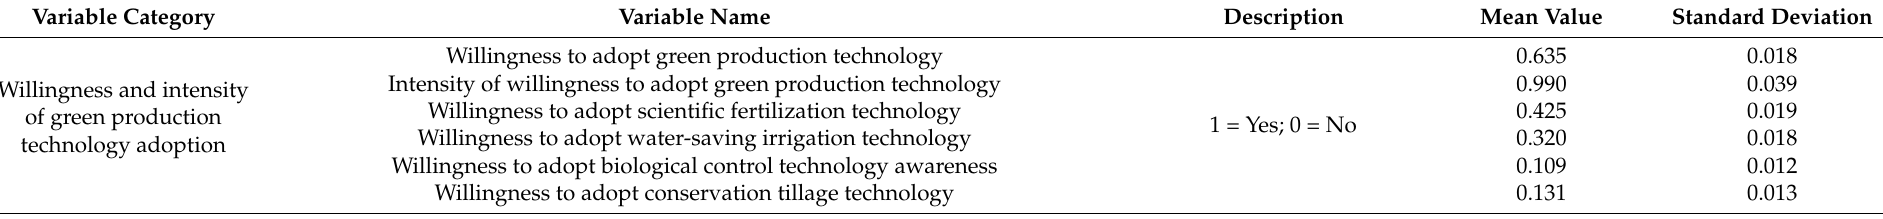
Table 1. Variable definition and descriptive